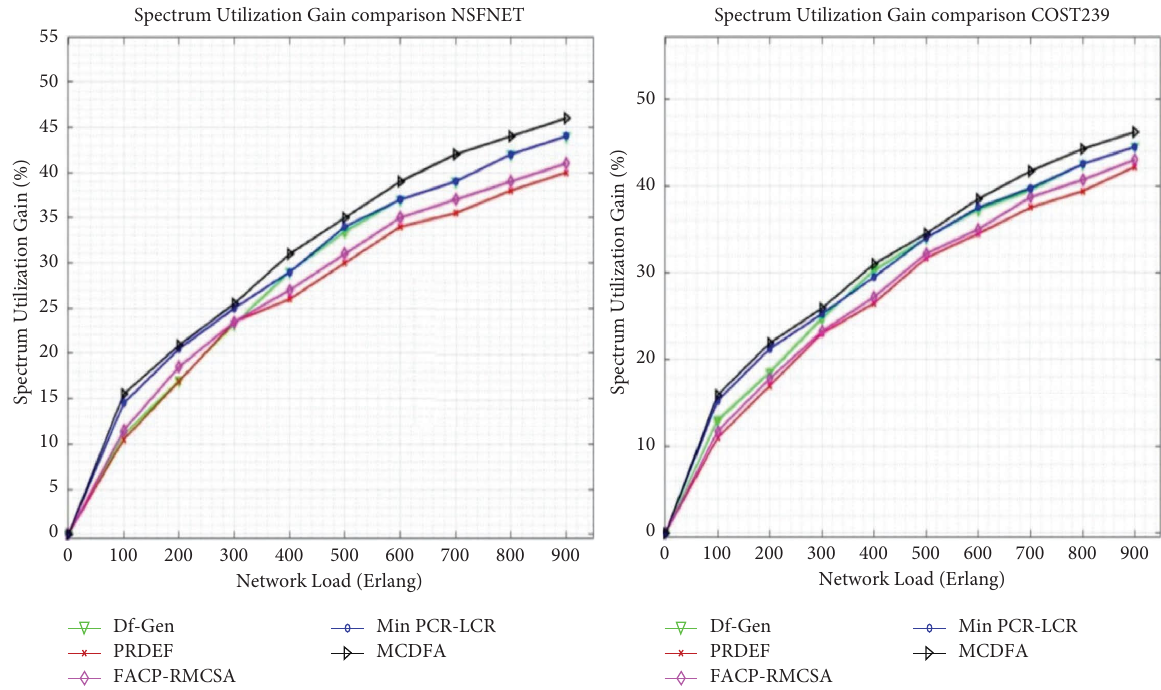
Figure 12: Te spectrum utilization gain (SUG) for NSFET and COST239.